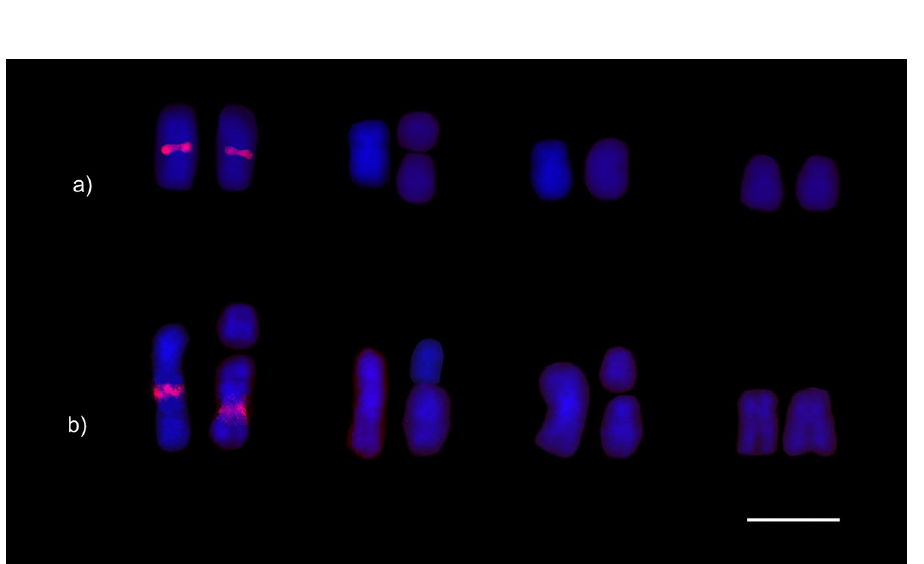
Figure 6. Karyotypes of Mycocepurus smithii from the asexual population marked via the FISH technique showing the presence of 18S rDNA genes (red regions) in two chromosomes for the karyomorphs ( a ) 2n =9 and ( b ) 2n = 11. Scale bar represents 5